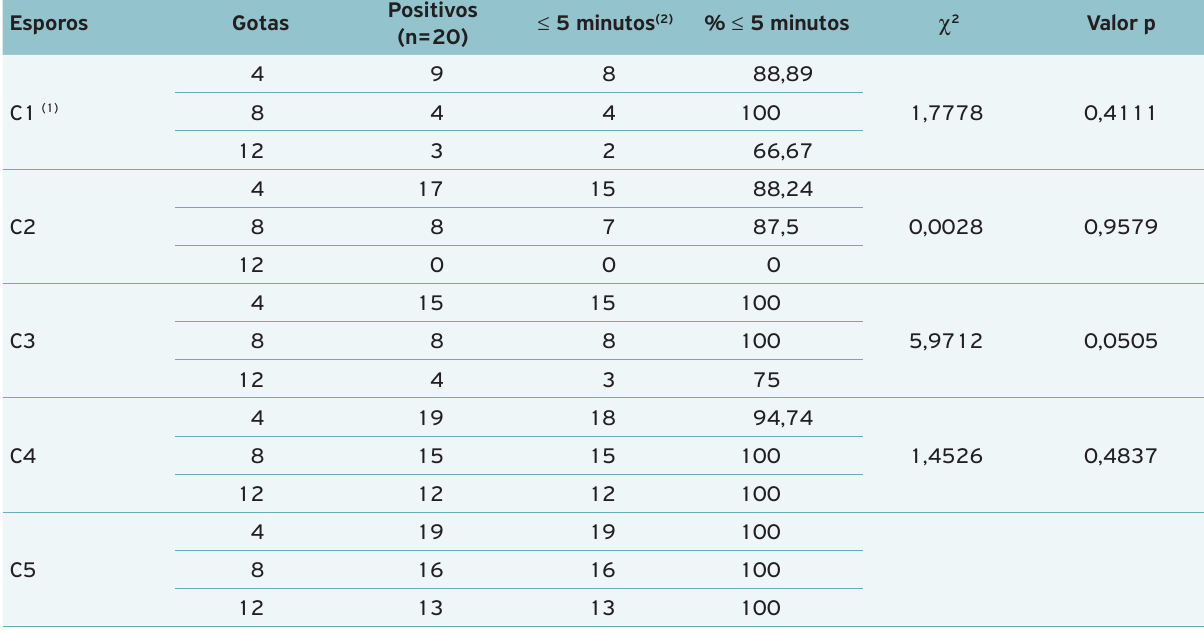
Tabela 3. Comparação entre as quantidades de gotas da solução extratora utilizadas dentro de cada classe de número de esporos, para tempo de ocorrência dos resultados positivos, pelo teste do qui-quadrado a 5% de significância.